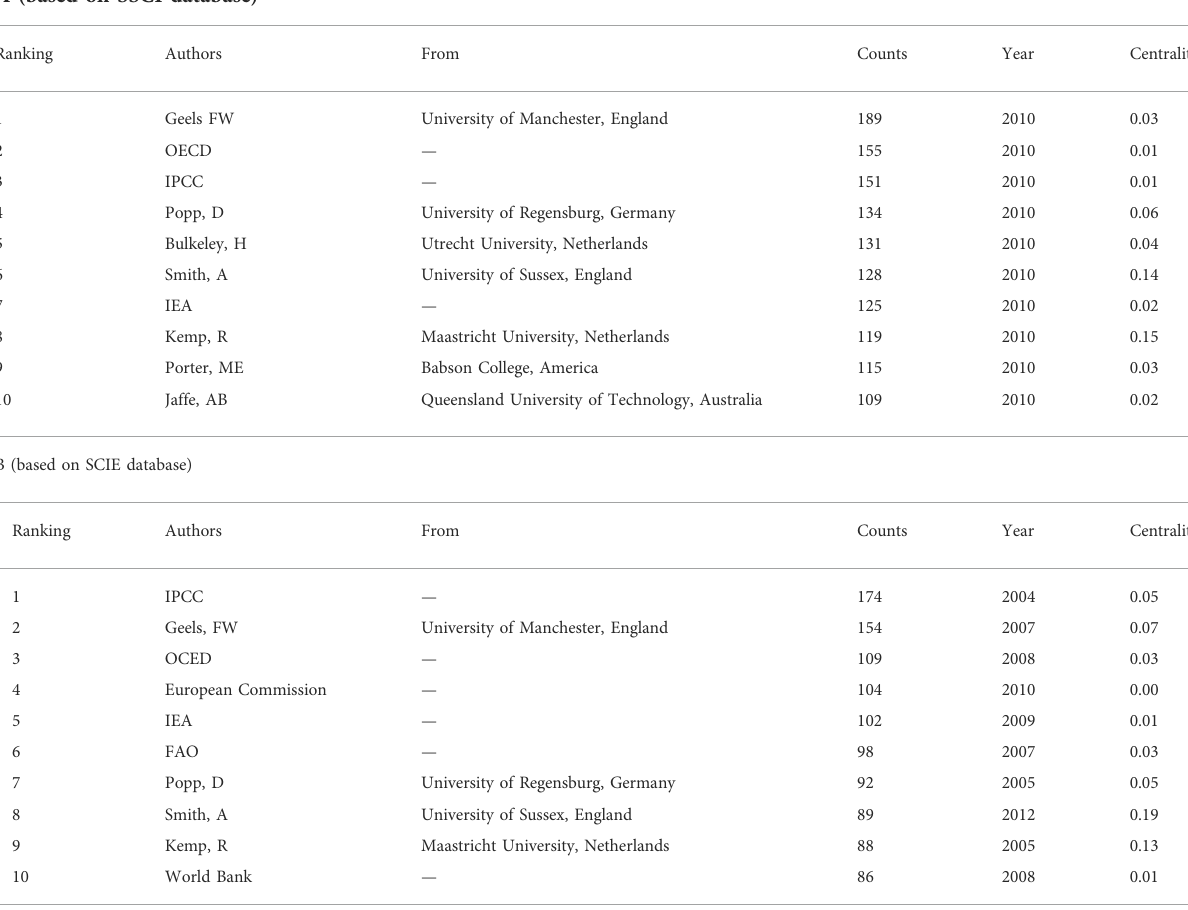
TABLE 4 Top 10 most cited authors in climate innovation